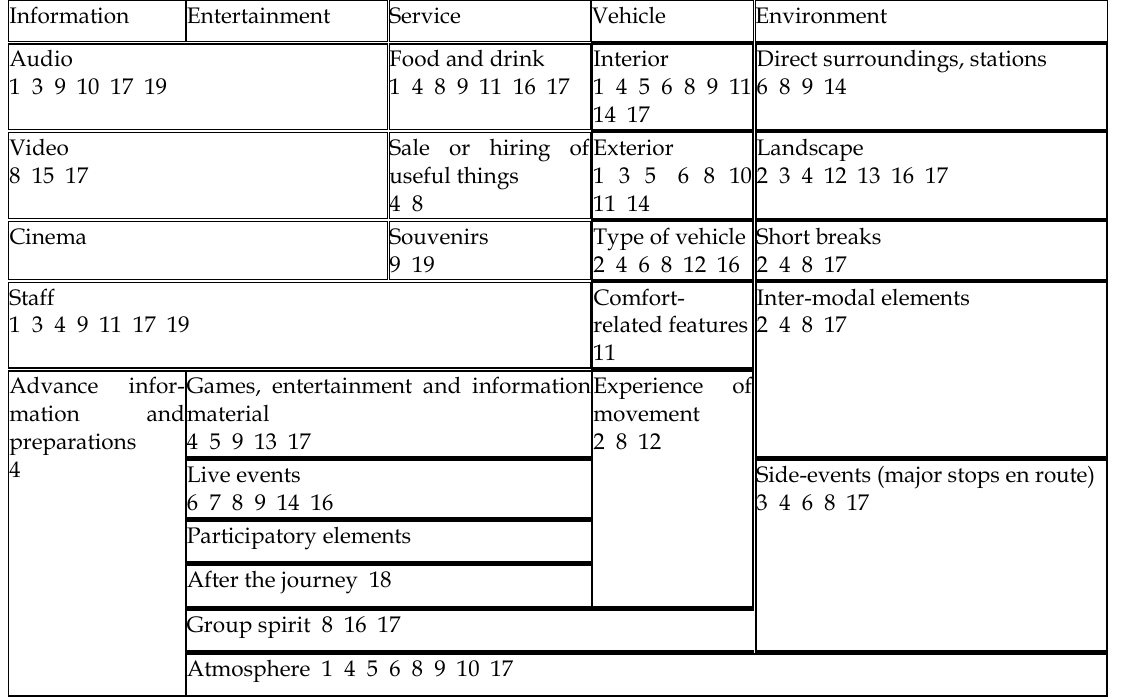
Table 2. Experience elements addressed in the case studies (author’s depiction)